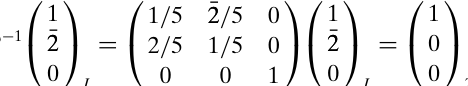
, G = P (cid:2) 442 G